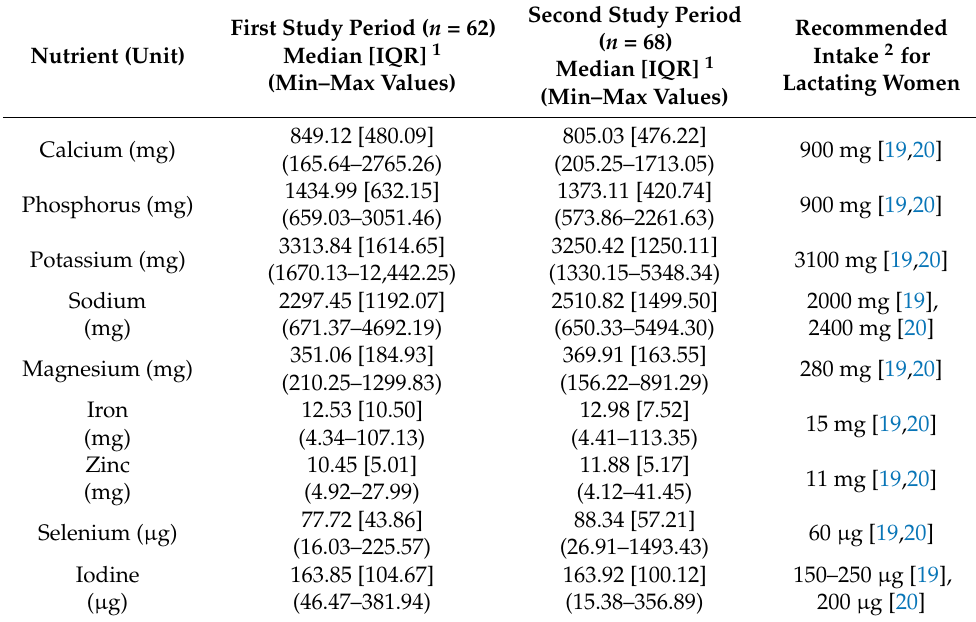
Table 3. Mineral intakes among the participants ( n =